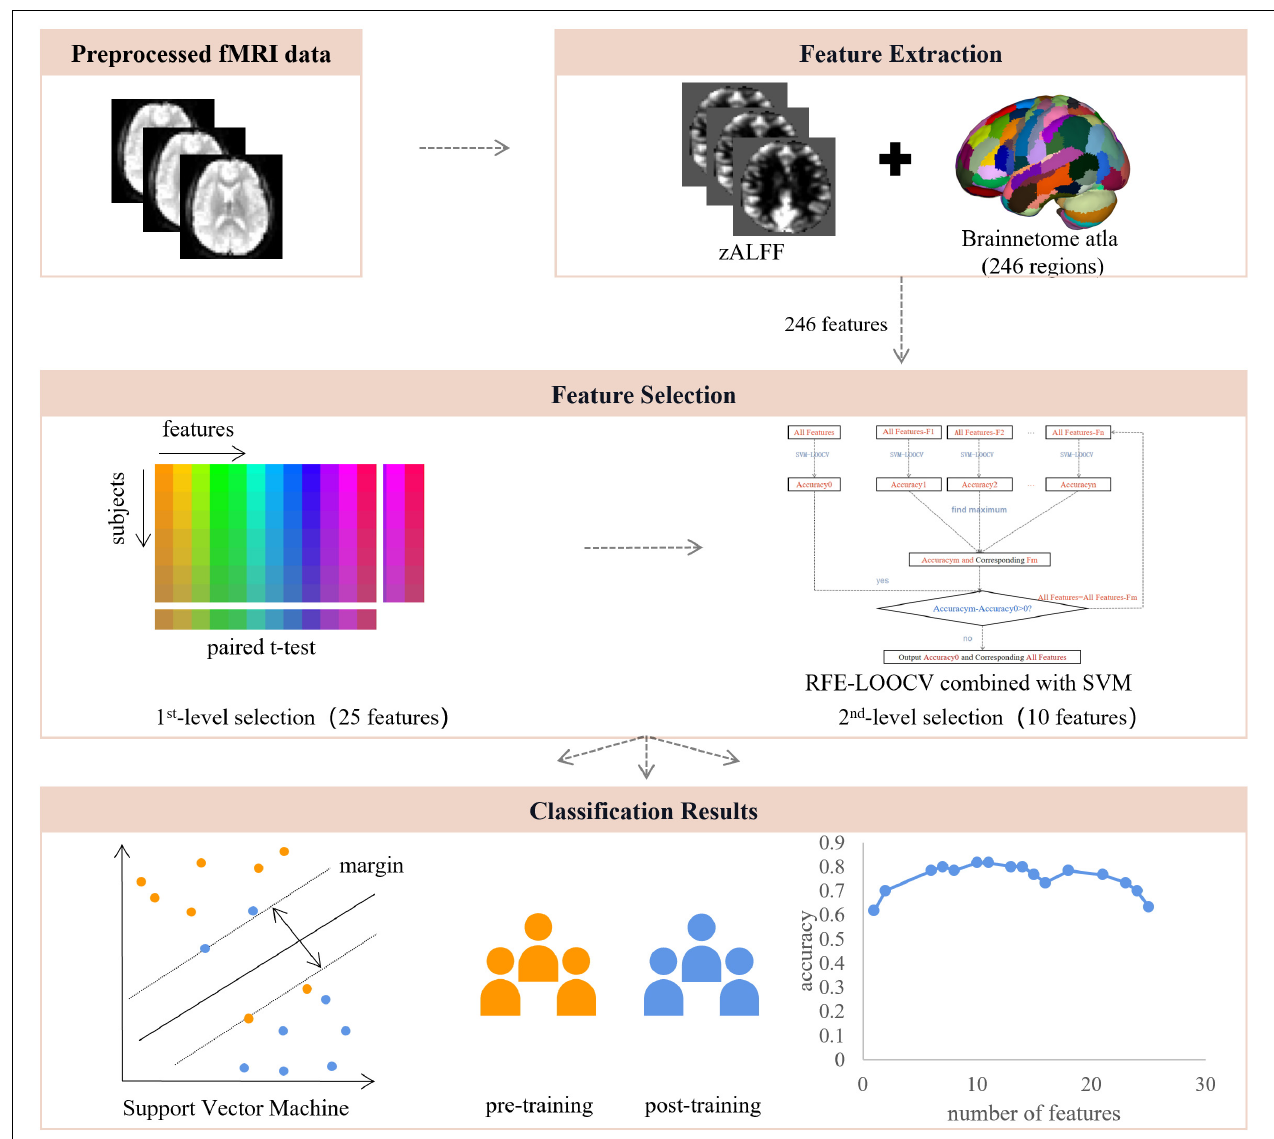
FIGURE 1 | The pipeline of data analysis. After the resting-state fMRI data were preprocessed, voxel-wise and region-wise amplitudes of low-frequency fluctuations were extracted and used for feature selection, which consisted of two steps, including region-wise paired t -test and recursive feature elimination embedded in a leave-one-out cross-validation framework, resulting in 10 features of highest discriminative power. These features were used for SVM modeling with LOOCV. ALFF, amplitude of low-frequency fluctuations; RFE, recursive feature elimination; LOOCV, leave-one-out